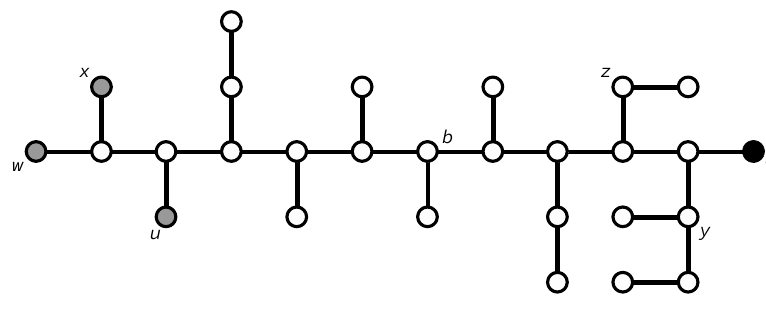
Fig. 13: Diagram of T 4